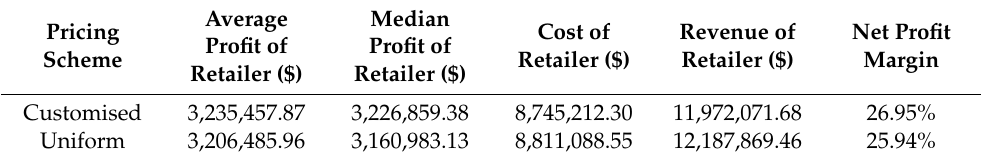
Table 5. Results of retailer under customised and uniform pricing schemes.